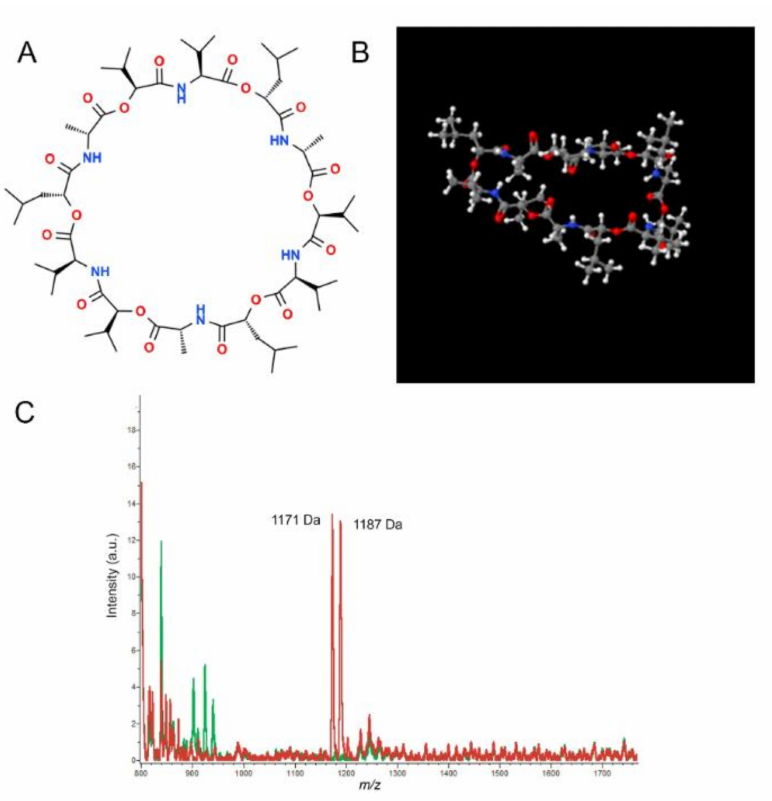
Figure 4. The 2D ( A ) and 3D ( B ) chemical structure of cereulide from ChemSpider (Royal Chemical Society). ( C ) Mass spectra of B. cereus strains / isolates, emetic strain in red, non-emetic strains in green (from